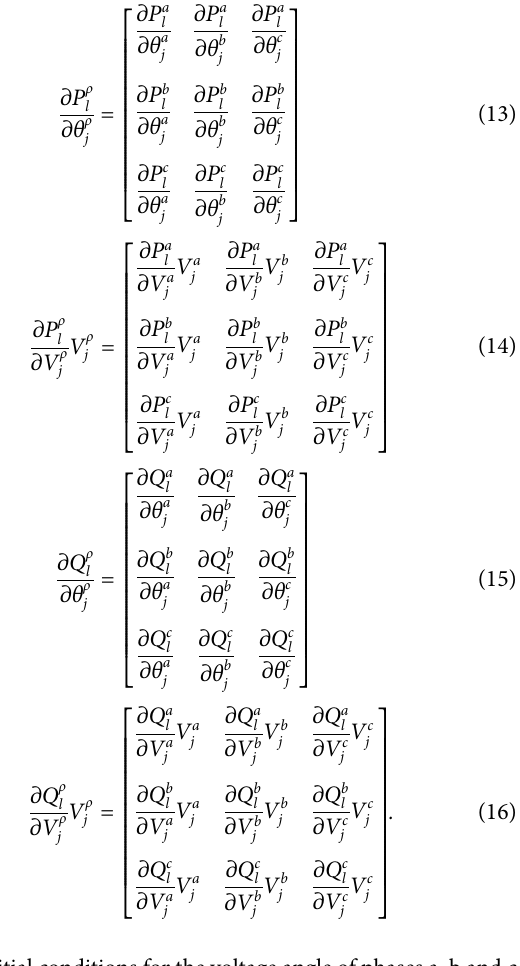
The initial conditions for the voltage angle of phases a, b and c are assigned as 0, − 2 π and − 2 π 3 3